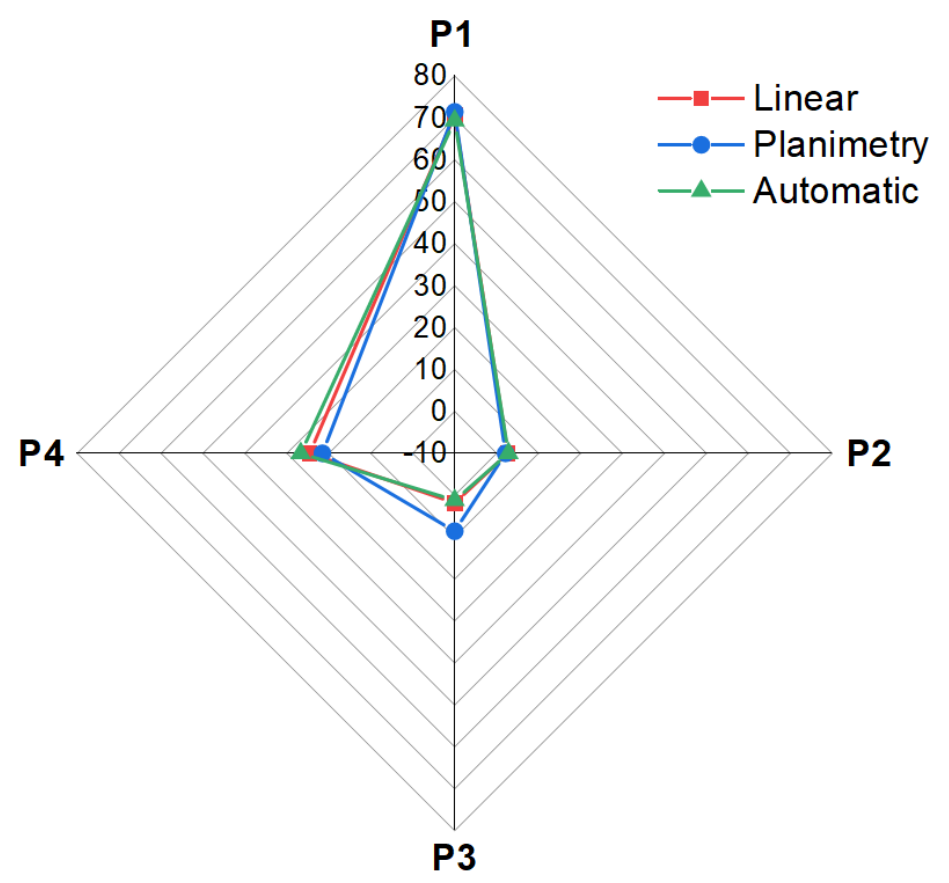
Figure 18. Spider chart presenting the results of image analysis obtained using traditional (linear and planimetry) and automated methods.